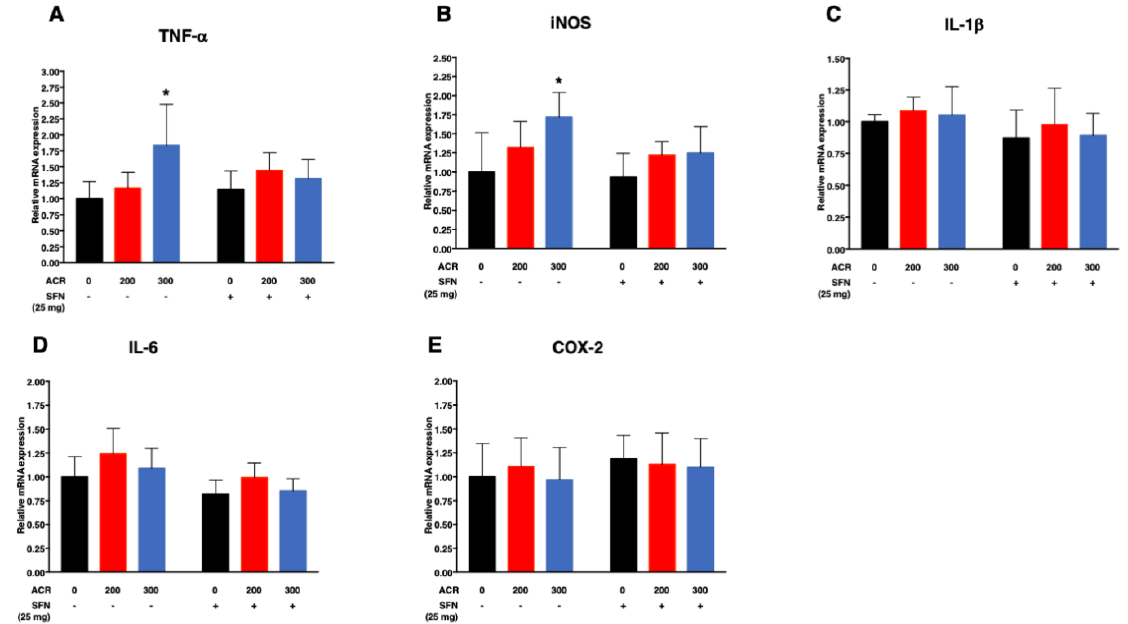
Figure 7. Effects of exposure to acrylamide and treatment with sulforaphane on relative mRNA expression of pro- inflammatory cytokines in the cerebral cortex; TNF- α ( A ), iNOS ( B ), IL-1 β ( C ), IL-6 ( D ) and COX-2 ( E ) after exposure to acrylamide for 4 weeks. Data are mean ± SD. * p < 0.05, compared to the corresponding treatment control (by analysis of variance (ANOVA) followed by Dunnett’s multiple comparison), ( n =